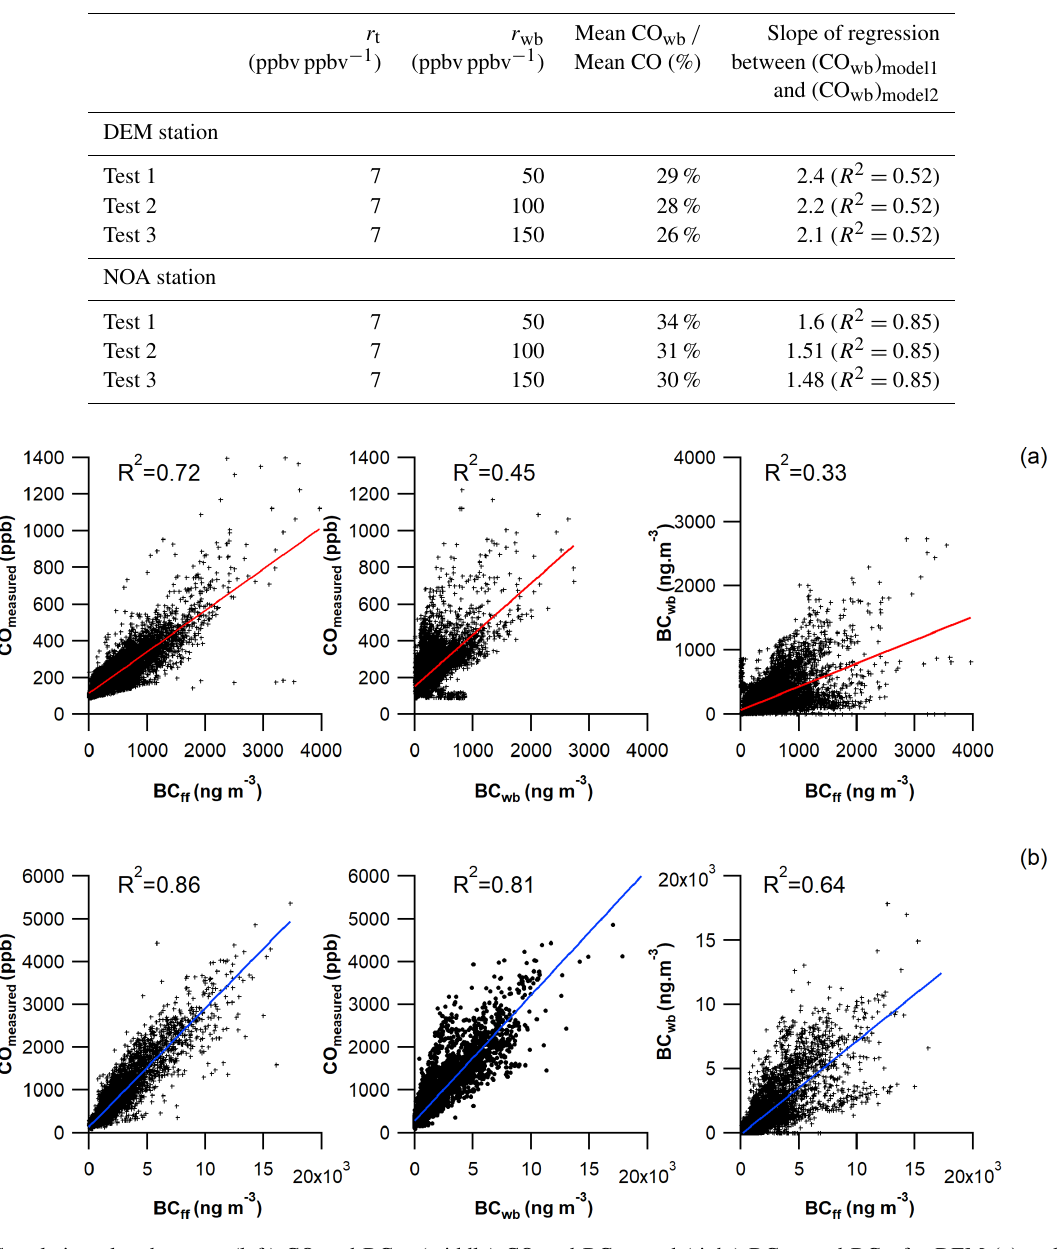
Figure 7. Correlation plots between (left) CO and BC ff , (middle) CO and BC wb and (right) BC wb and BC ff for DEM (a) and NOA (b)